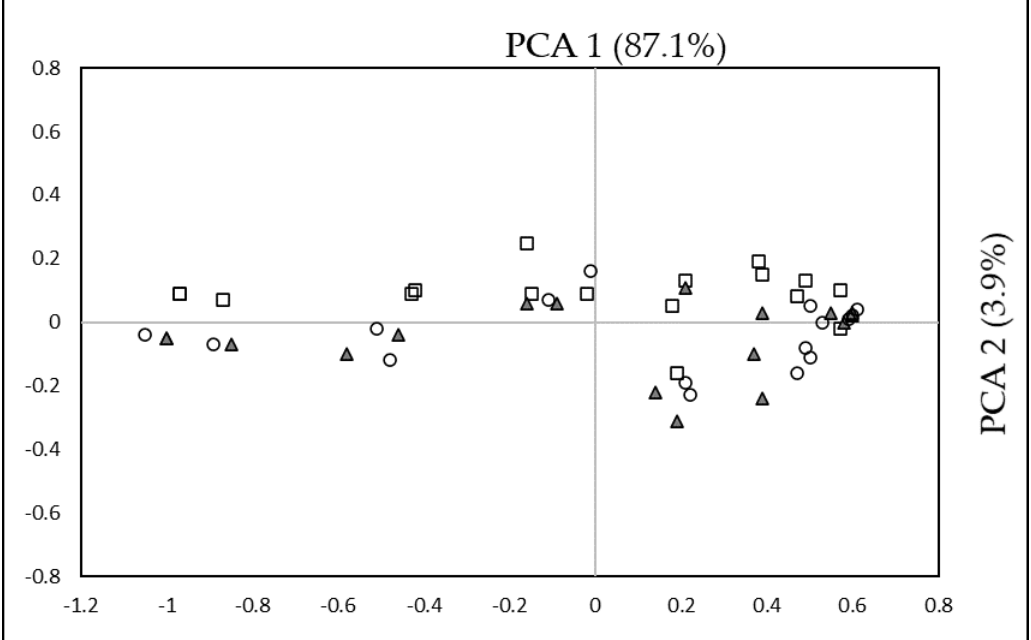
Figure 2. Principal component analysis related to the content of biogenic amines in Colombian criollo cocoa samples. Legend: empty square, T1 (raw cocoa beans); gray triangle, T2 (120 ◦ C for 22 min) ; empty circle, T3 (135 ◦ C for 15 min).